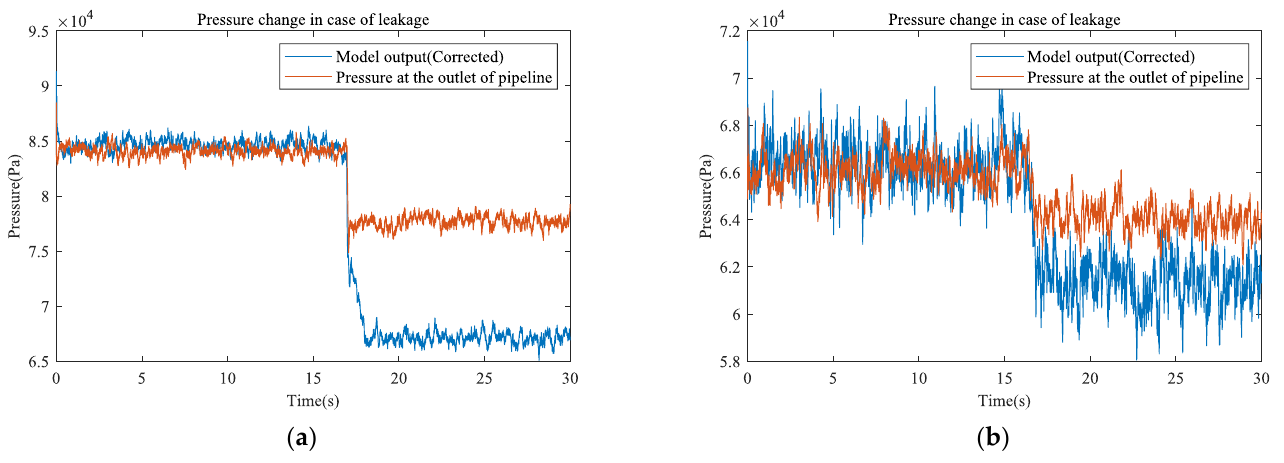
Figure 6. Comparison between the model output and the actual pressure change value at the outlet of the pipeline when leakage occurred. ( a ) Large leakage; ( b ) small leakage.